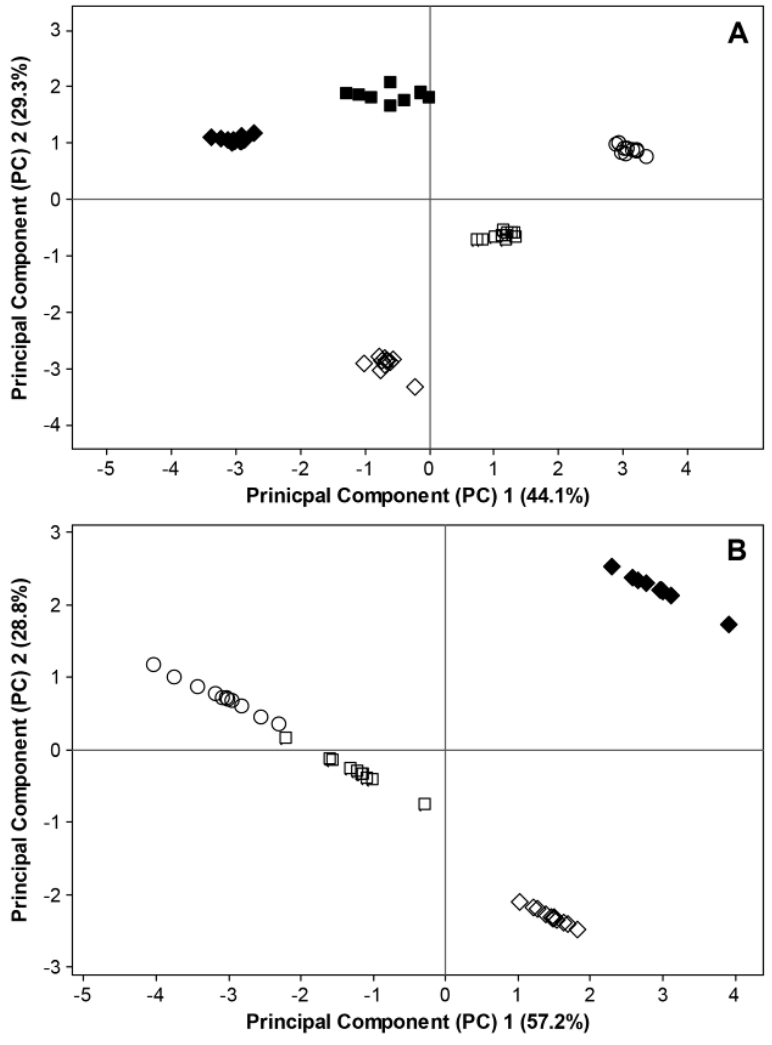
Figure 8. Principal component analysis (PCA) of interactivities in the phyllosphere microbiome of organically grown strawberries on the basis of Shannon diversity indices, Chao1 estimators, temperature and precipitation data for ( A ) fungal ITS rRNA sequences and ( B ) bacterial 16S rRNA sequences at different phenological stages (  = BBCH 60,  = BBCH 73,  = BBCH 93). Filled and open symbols represent data generated in 2011 and 2012, respectively. For 2011, data considering fungal ITS sequences and bacterial 16S rRNA sequences are excluded at BBCH 60 due to missing temperature data. Data for bacterial 16S rRNA sequences are excluded at BBCH 73 due to insufficient bioinformatic